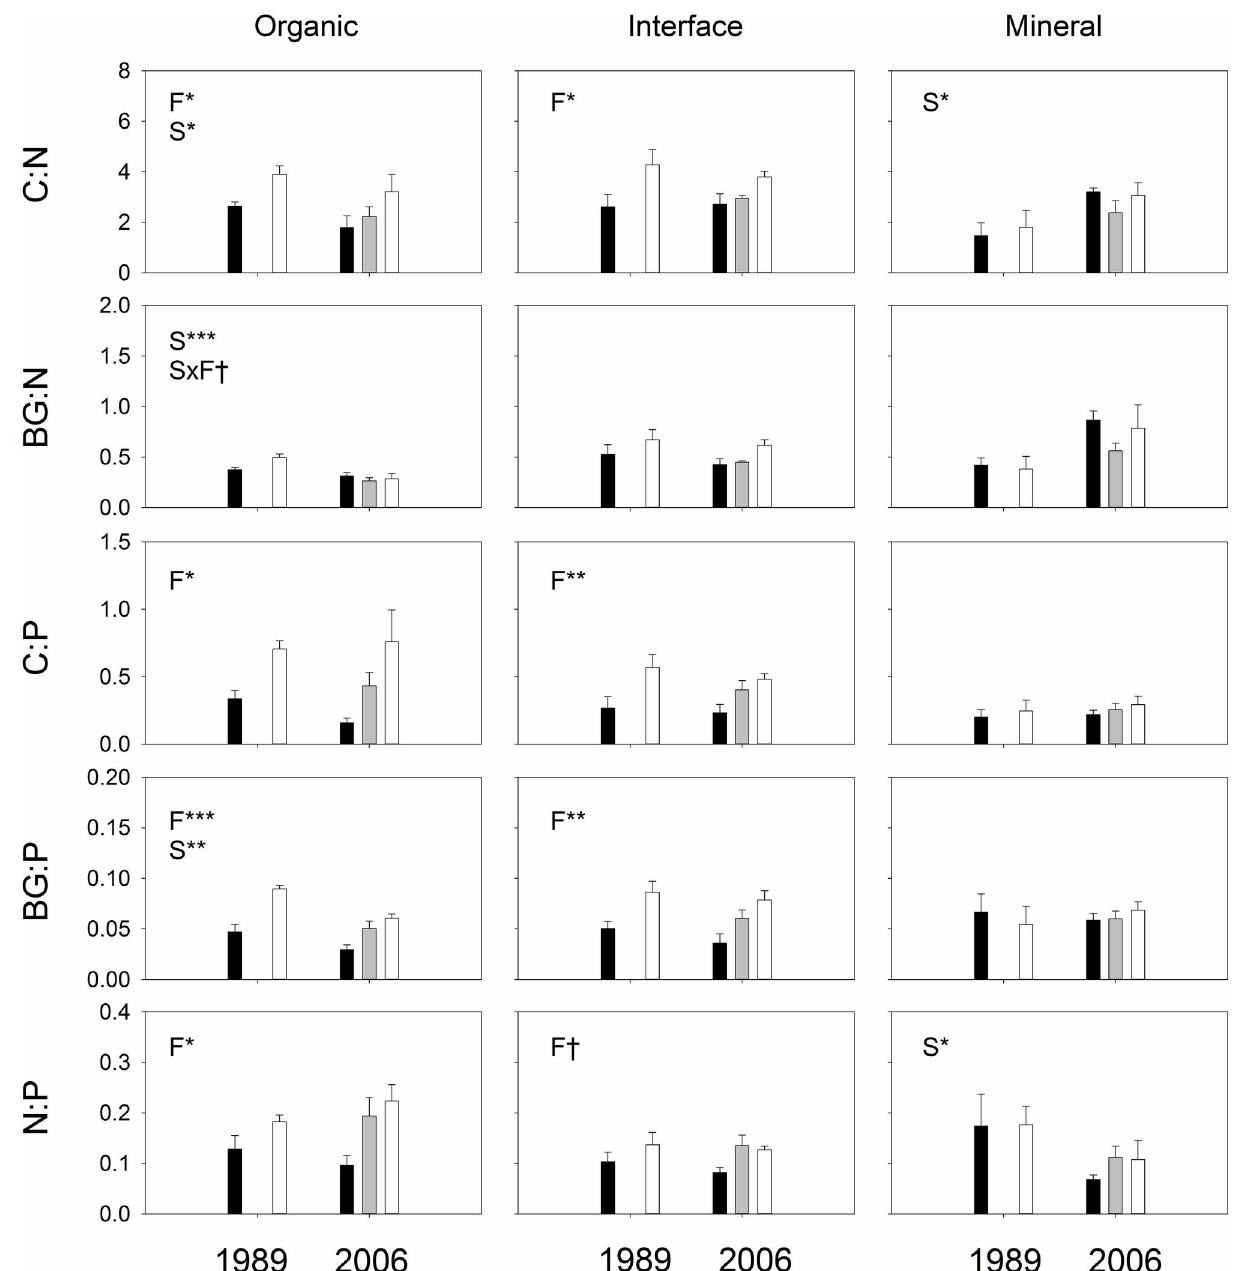
Figure 3. Stoichiometry of potential enzyme activities in the three soil profiles collected assayed at 15 °C. C, N and P represent potential enzyme activities of (BG+CB+XYL+AG), (NAG+LAP) and PHOS, respectively. Statistically significant effects found by mixed-effect ANOVA are shown in panels: F; fertilization treatment (control, low and high fertilizations), S; site (i.e., 1989 and 2006 sites), and F×S; interaction between F and S. Symbols indicate: †; p ≤ 0.10, *; p ≤ 0.05, **; p ≤ 0.01, ***; p ≤ 0.001.